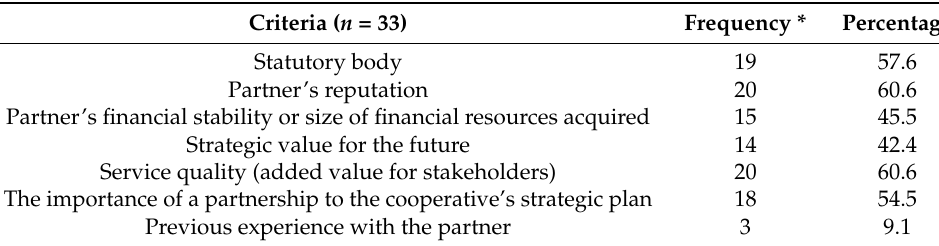
Table 3. The partner-selection criteria applied by the